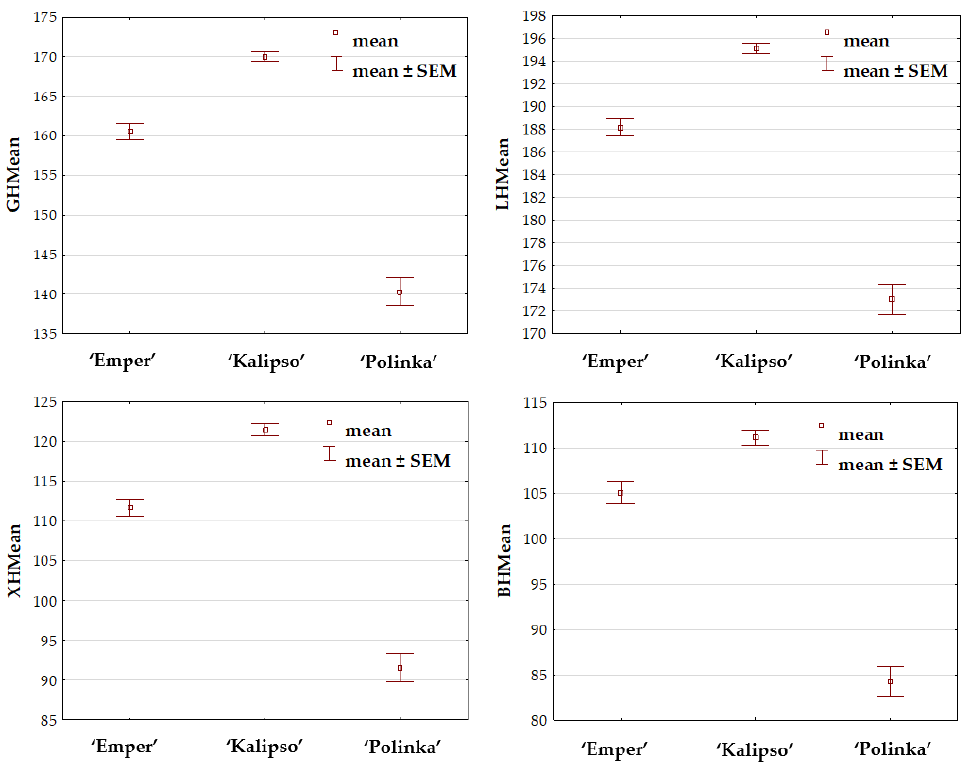
Figure 4. The mean values of selected textures from color channels G , L , X , and B of plum stone images; SEM—standard error of the mean.